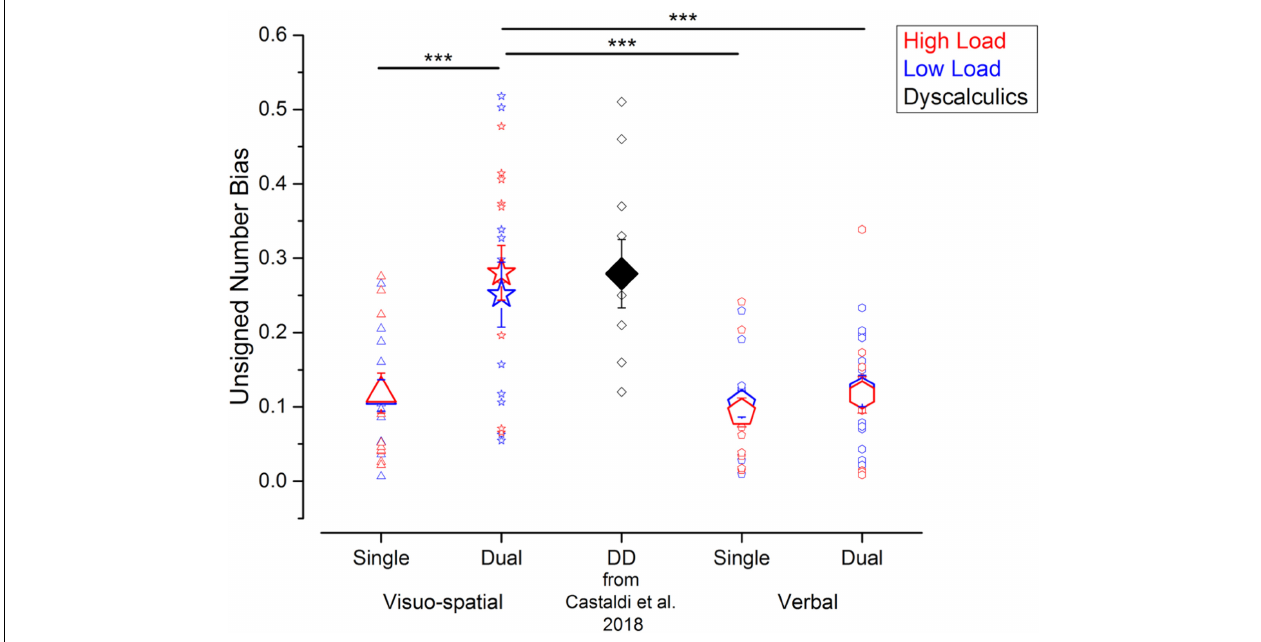
FIGURE 4 | Interference from the unattended dimension in the numerosity discrimination tasks – unsigned bias. Unsigned biases measured in the different experiments performed in the current study (blue and red symbols) and in a group of DD participants (black symbol, for qualitative comparison) tested by Castaldi et al. (2018). Symbol size and color correspond to the average and individual biases and to the different loads in the secondary task. *** p < 0.005.